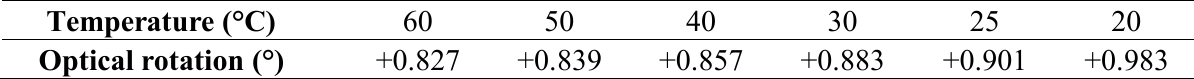
Table 1. Optical rotation of wheat amylose at 589